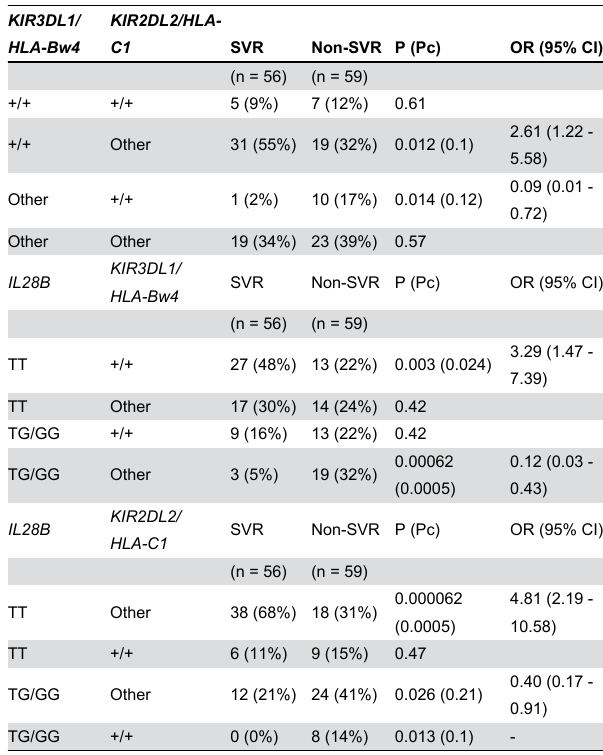
Table 2. Frequency of IL28B genotype, KIR3DL1 / HLA-Bw4 , and KIR2DL2 / HLA-C1 combinations in 56 patients with a sustained virological response (SVR) and 59 patients with a non-SVR to pegylated interferon and ribavirin therapy of chronic hepatitis